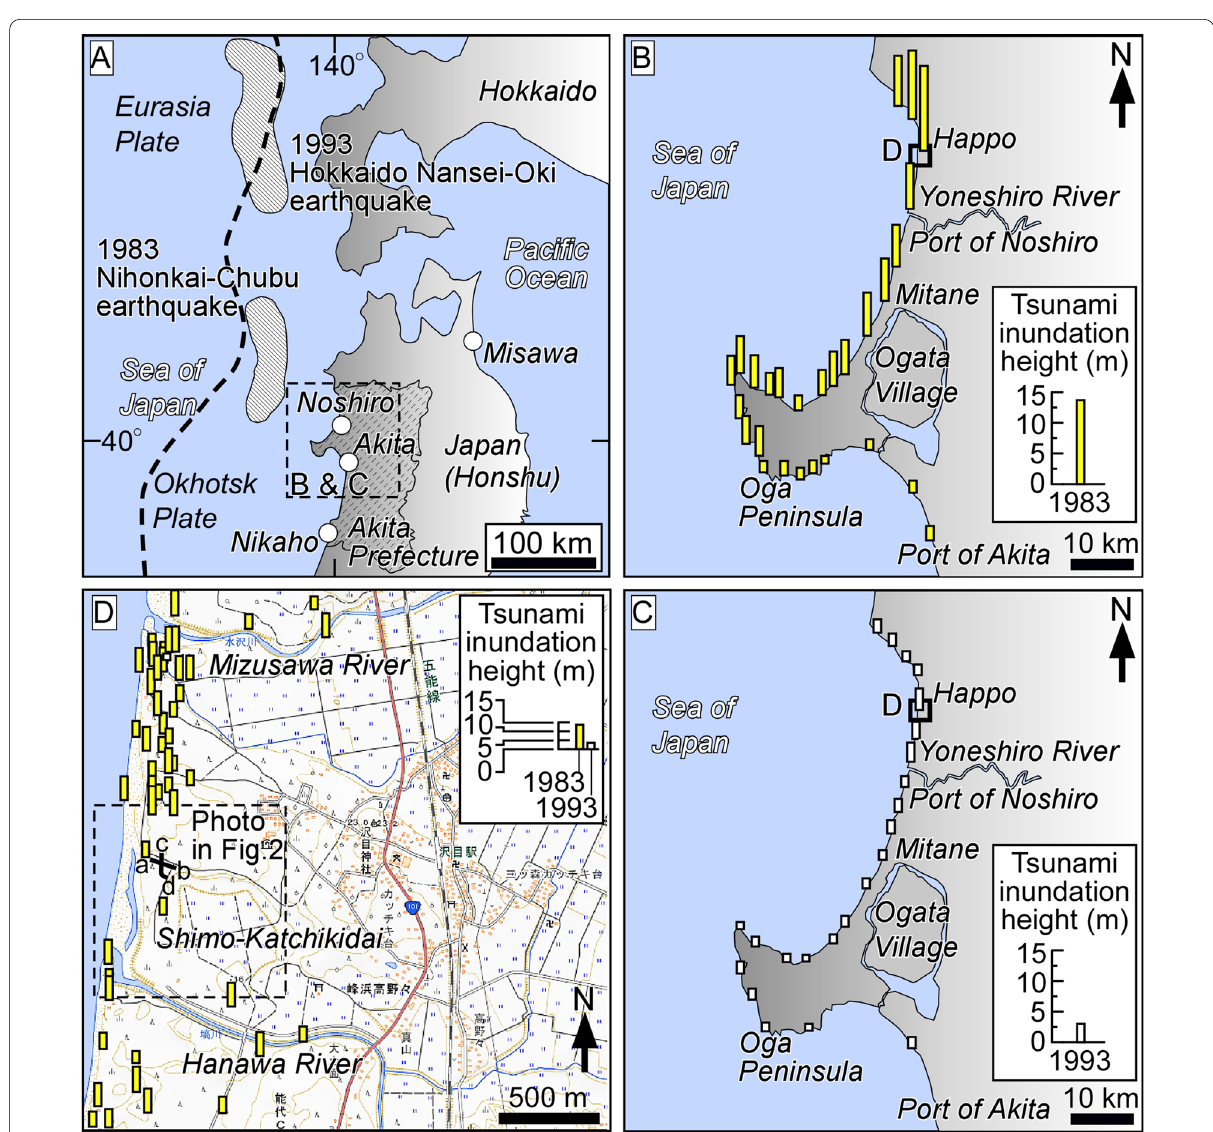
Fig. 1 Outline of the study area. A Rupture area of the 1983 Nihonkai-Chubu earthquake (based on Aida 1984) and 1993 Hokkaido Nansei-Oki earthquake (based on Tanioka et al. 1995). B Tsunami inundation height distribution of the 1983 Nihonkai-Chubu tsunamis. The tsunami inundation heights are based on Japan Society of Civil Engineers, Investigation Committee of Nihonkai-Chubu earthquake (1986) and Ministry of Land, Infrastructure, Transport and Tourism (2013). C Tsunami inundation height distribution of the 1993 Hokkaido Nansei-Oki tsunamis. The tsunami inundation heights are based on Japan Society of Civil Engineers, Investigation Committee of Nihonkai-Chubu earthquake (1986) and Ministry of Land, Infrastructure, Transport and Tourism (2013). D Topographic map of the study area. Tsunami inundation heights of the 1983 and 1993 tsunamis were obtained from the tsunami trace database (https:// tsuna mi- db. irides. tohoku. ac. jp/ tsuna mi/ mainf rame.